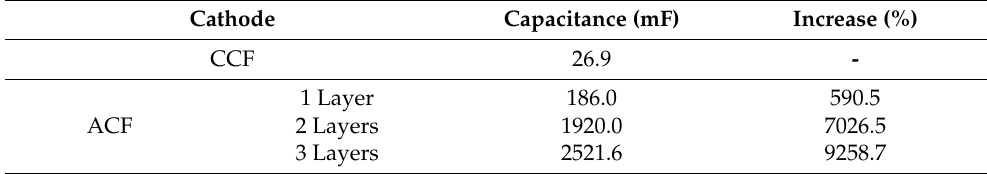
Table 2. Capacitance of the commercial carbon felt (CCF) and of the layered activated carbon felt (ACF).